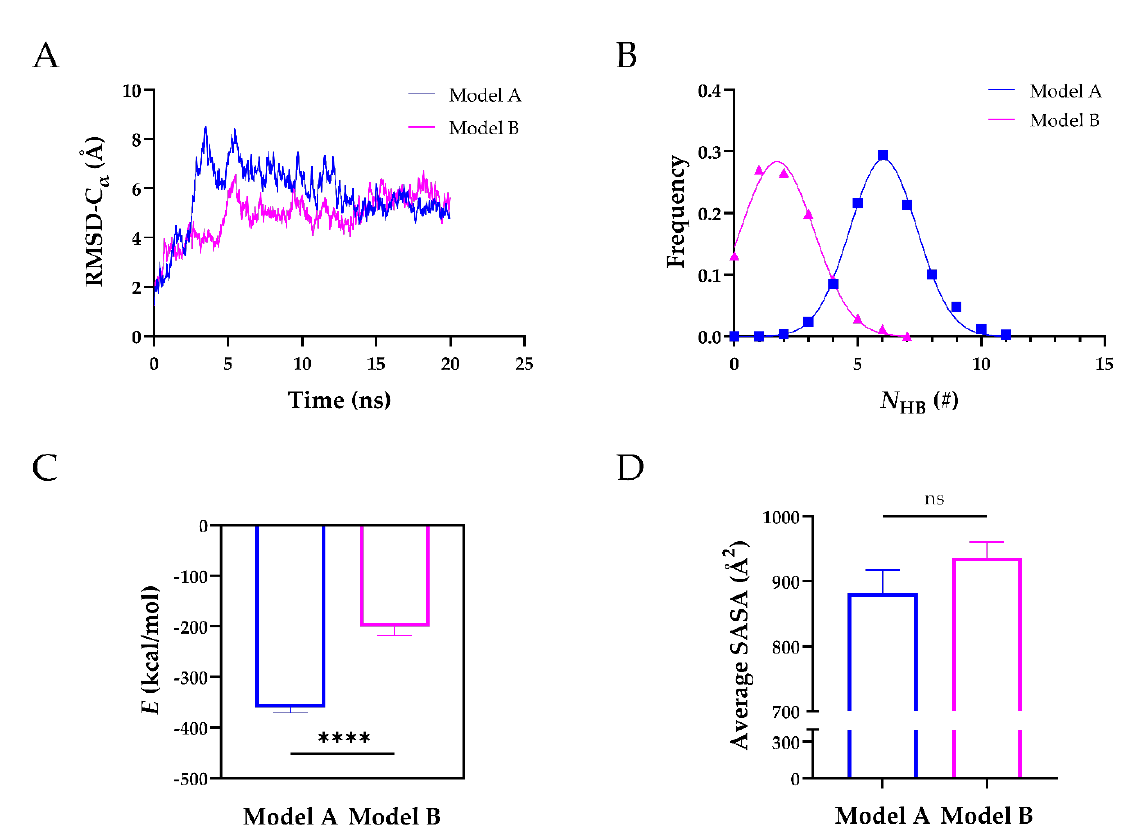
Figure 2. The structural stability of Model A was superior to that of Model B during the 20 ns equilibrium. ( A ) The time courses of Cα -RMSD for Model A and Model B; ( B ) the number of H-bonds ( N HB ) frequencies of the two models were fitted by Gaussian distribution; ( C ) plots of the mean interaction energy ( E ) of two models; ( D ) plots of the average SASA on the interface of two models. Data were presented as mean ± SEM. Differences on the interaction energy and average SASA of two models were analyzed with Student’s t -test (ns indicates not significant, **** indicates p < 0.0001, n = 20). Table 2. Residue interactions on the interface of Model A and Model B at equilibrium.